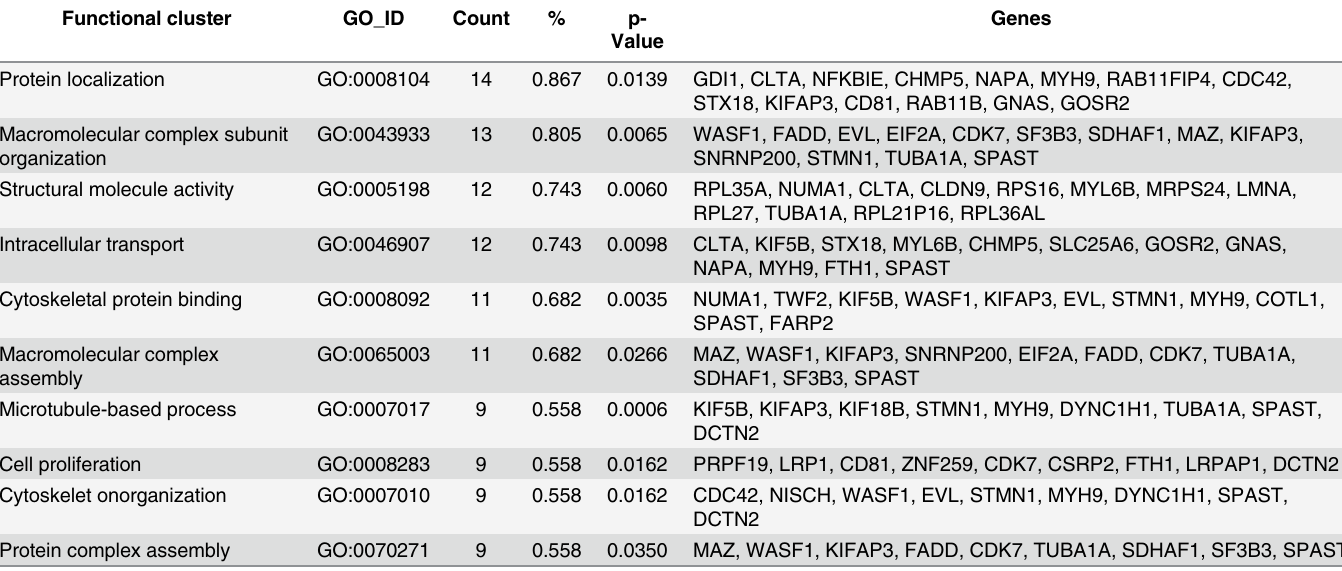
Table 2. Functional annotation of the top biomarker candidates. Functional cluster